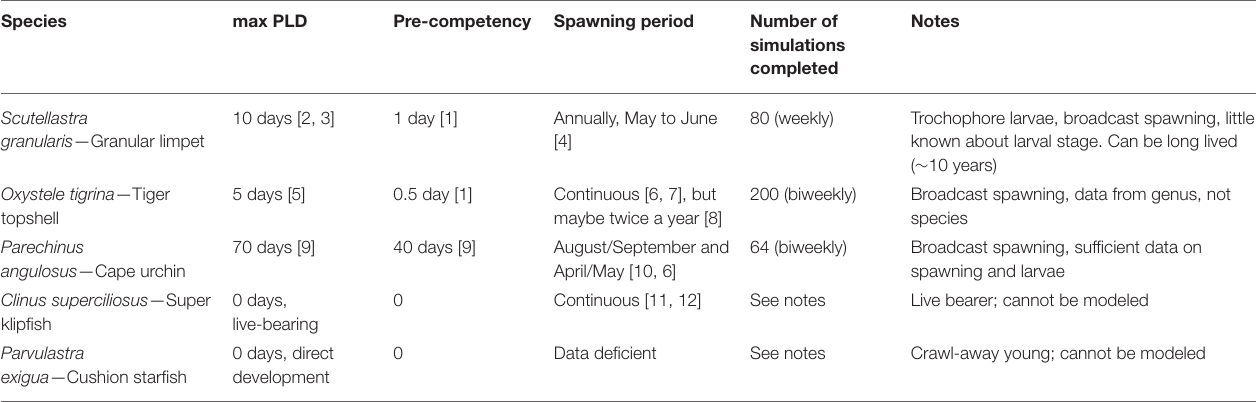
TABLE 2 | Species information used for modeling connectivity.